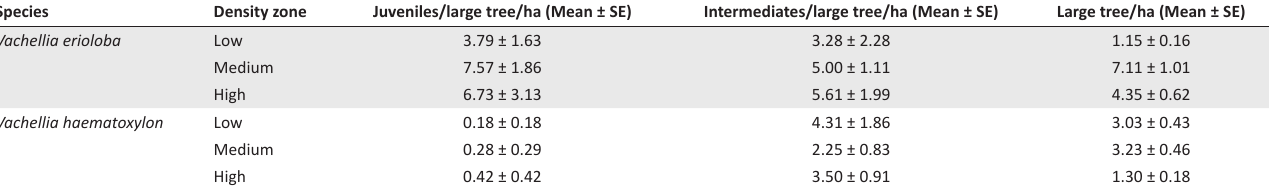
Values are means ± 1 standard error. SE, standard